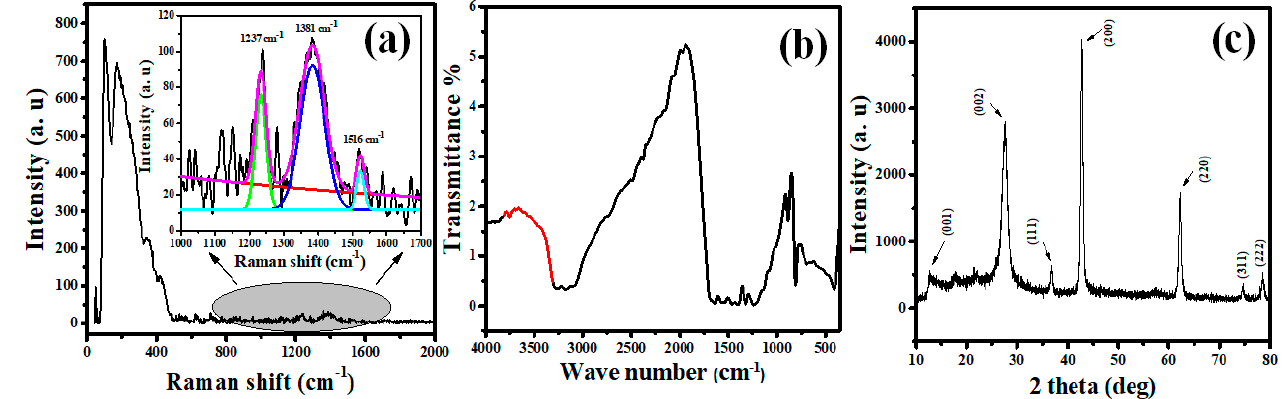
Figure 2. ( a ) Raman spectrum, ( b ) FTIR spectrum, and ( c ) XRD pattern of MGCN sorbent.